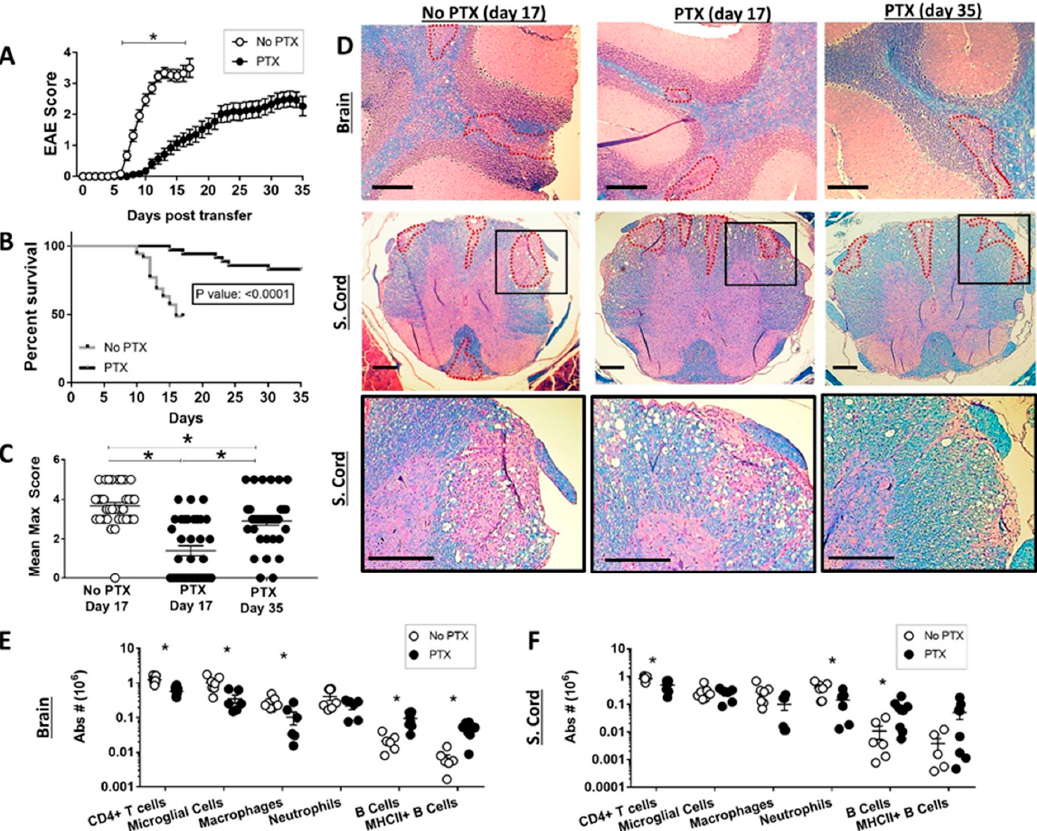
Figure 1. Pertussis toxin ameliorates disease in the Th17-EAE model. Myelin oligodendrocyte glycoprotein (MOG)-specific Th17 cells were transferred into recipient mice and treated with 250 ng pertussis toxin (PTX) intraperitoneally at day 0 and 2 post-transfer of cells. ( A ) Clinical scores of mice with Th17-EAE treated with PTX or PBS (No PTX). ( B ) Kaplan-Meier survival curve of Th-17 EAE mice treated with (PTX) or without (No PTX) at day 0 and 2 post-transfer. ( C ) Mean maximum score of mice treated with PTX or PBS (No PTX); n = 30 mice per group. Mann-Whitney tests were performed to determine statistical significance (* p < 0.05). Results compiled from 5 independent experiments. ( D ) Representative brain and